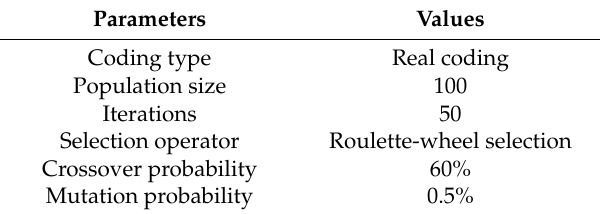
Table 3. Parameter settings of GA.